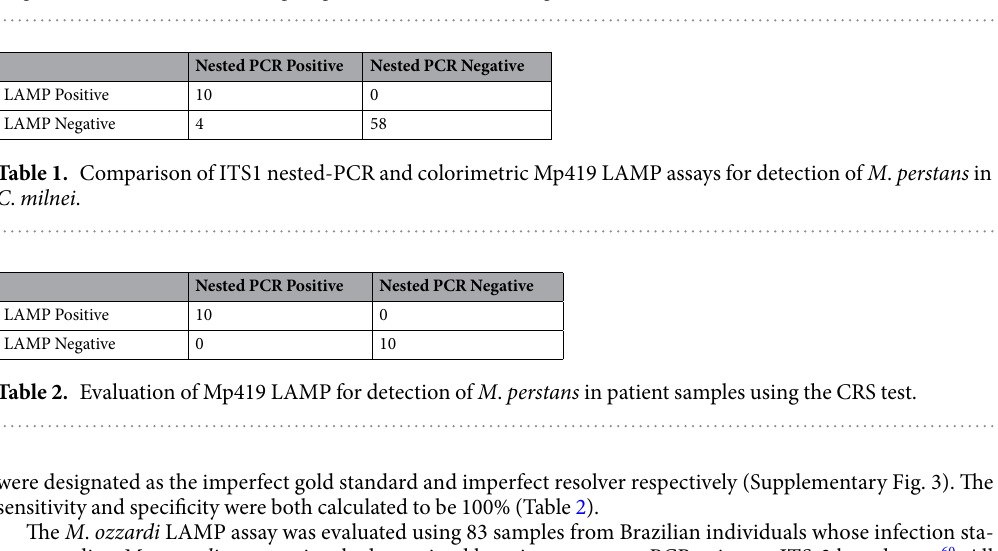
Figure 6. Sensitivity of the Mansonella LAMP assays. DNA from M . perstans ( A ) or M . ozzardi ( B ) ranging from 10–0.001 pg per reaction, was amplified using the primer sets targeting Mp419 or Mo2, respectively. Negative ( − ) controls containing 1 ng of HeLa DNA (New England Biolabs) were included.